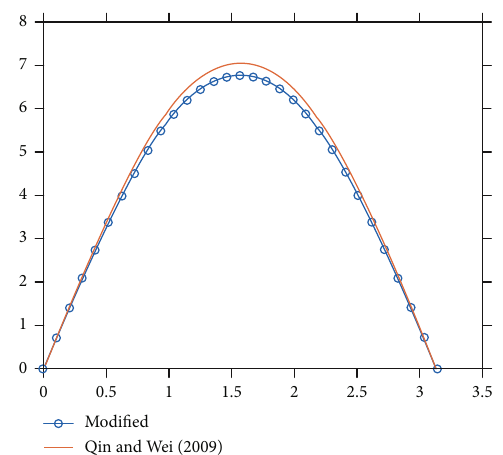
Figure 15: The variations of the system of equations (42) and the solution of the regularized system of equations (12) – (15) for p = 1 , k = 0 : 6 , α = 0 : 02 , and y = 1